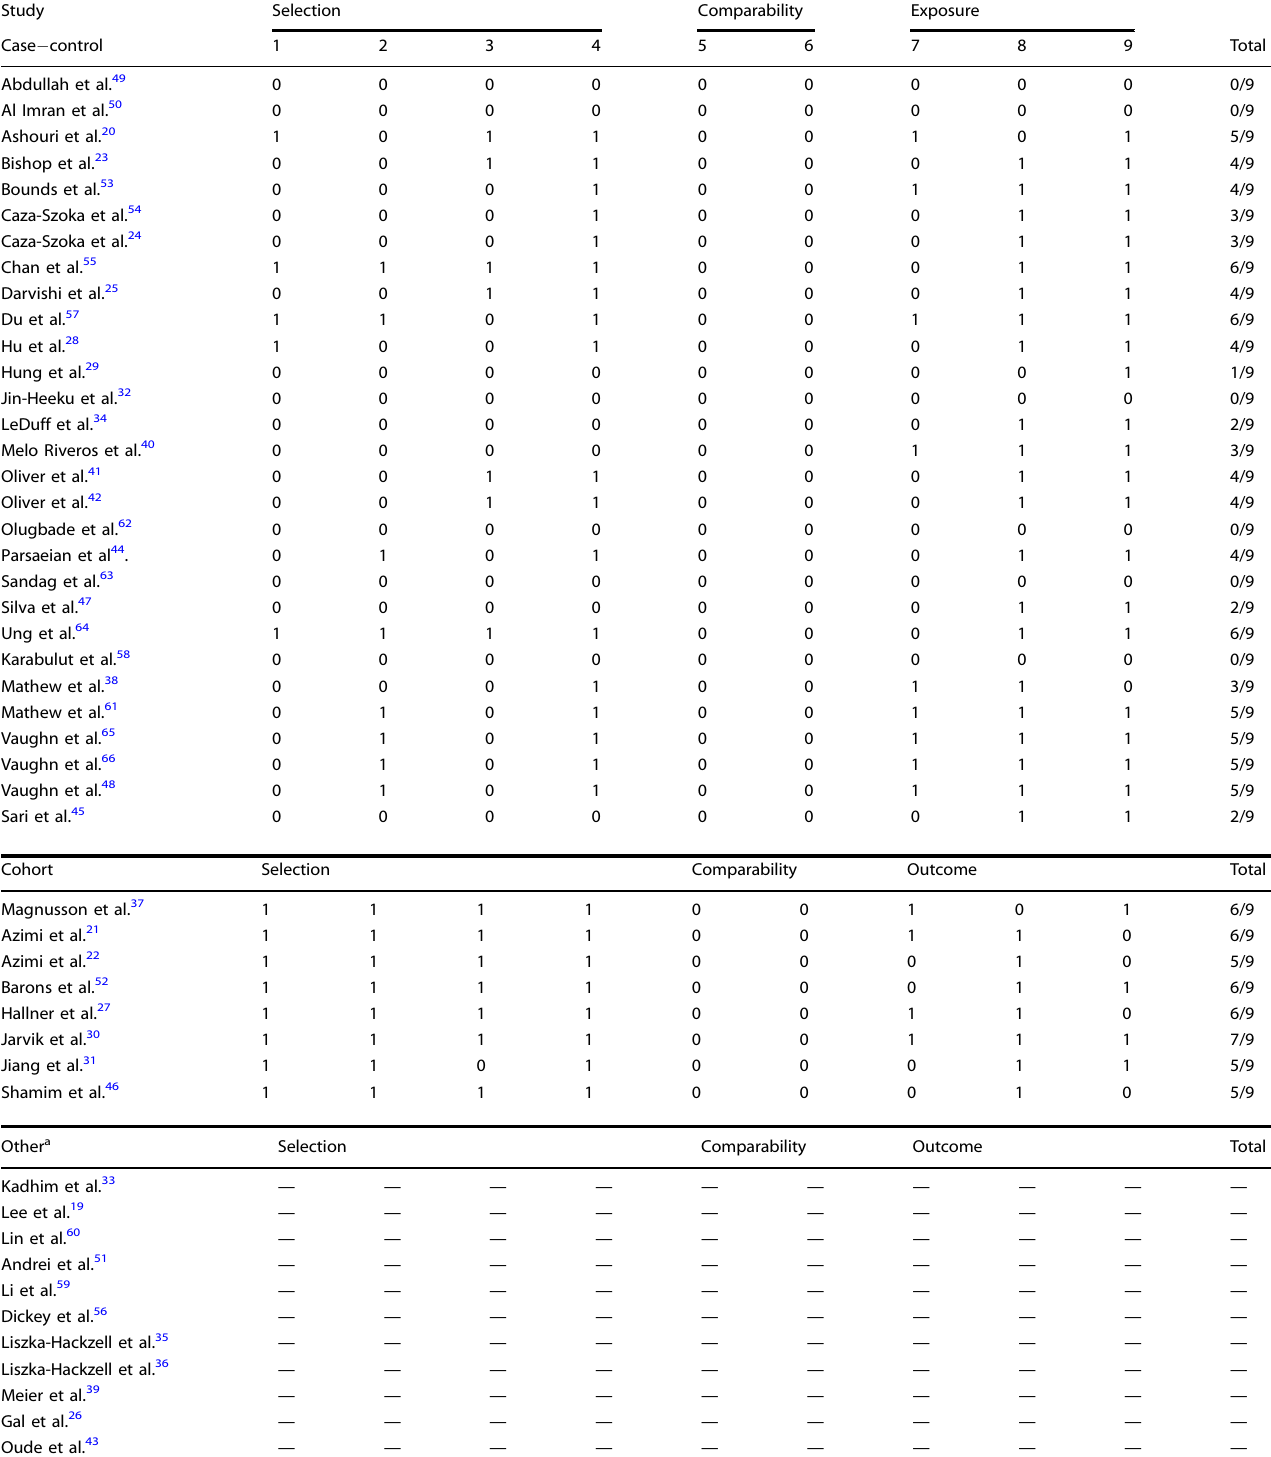
Table 2. Risk of bias assessment using the Newcastle-Ottowa